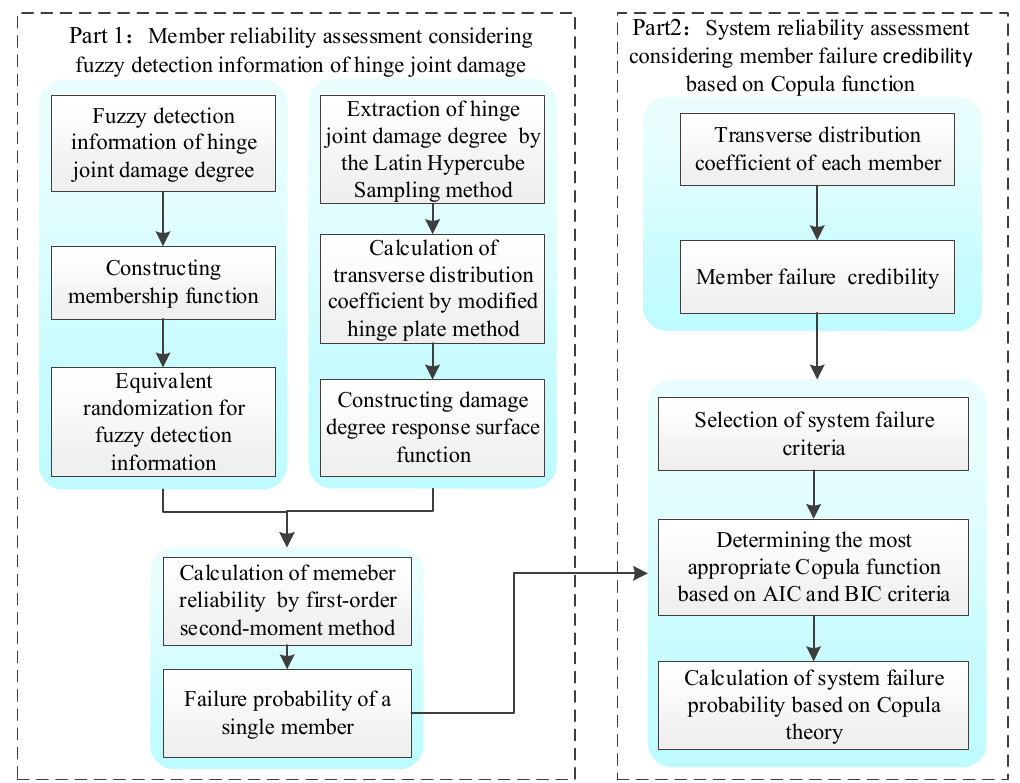
Figure 1. Flow chart of the reliability evaluation method proposed in this paper.